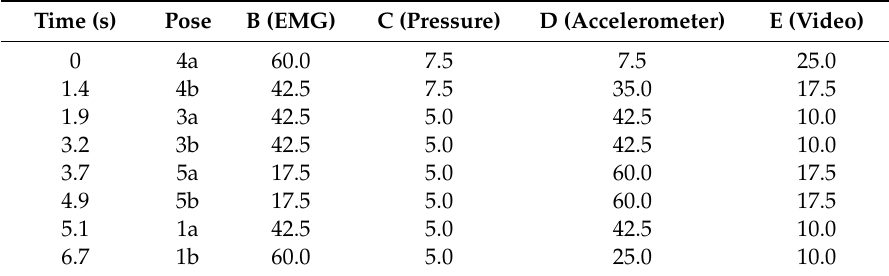
Table 5. From sensors (in %) to the compound action recognition, “searching on the